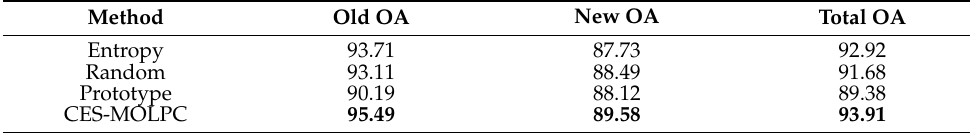
Table 5. Comparison of class exemplar selection methods on the RML2016.04c data set ( T = 2).